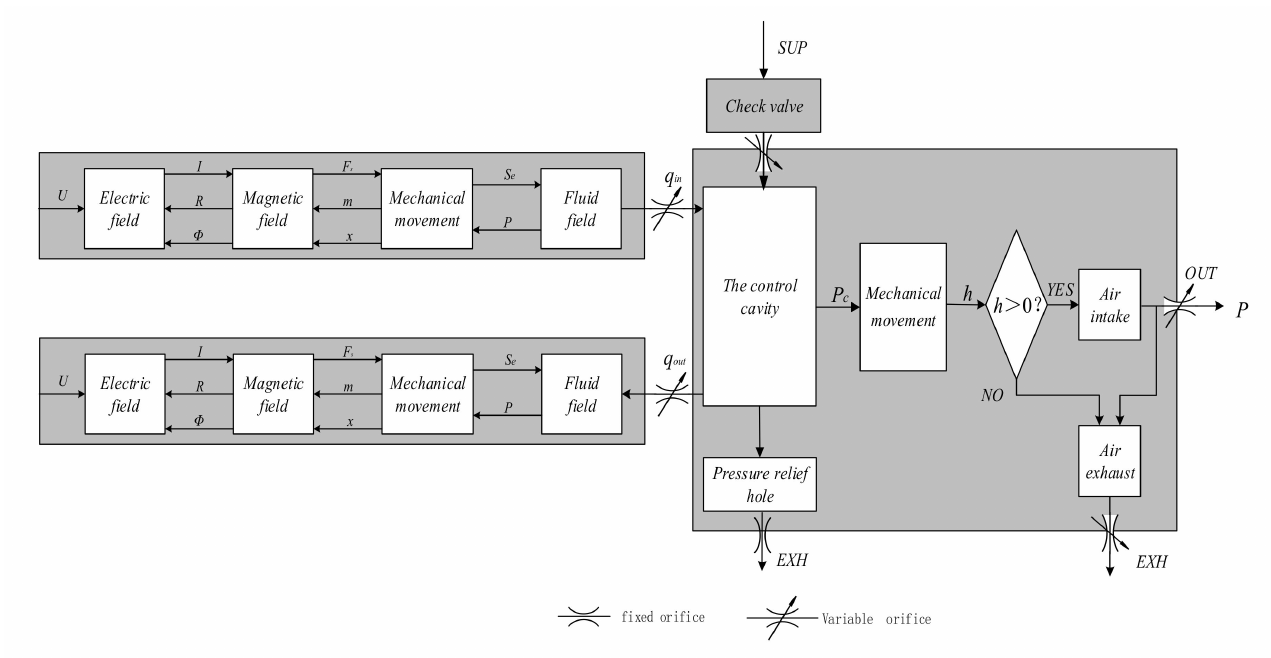
Figure 5. Coupling of subsystems in the simulation model for the automatic pressure regulating valve. Based on the coupled relation between each subsystem, the simulation model of the automatic pressure regulating valve shown in Figure 6 is established.